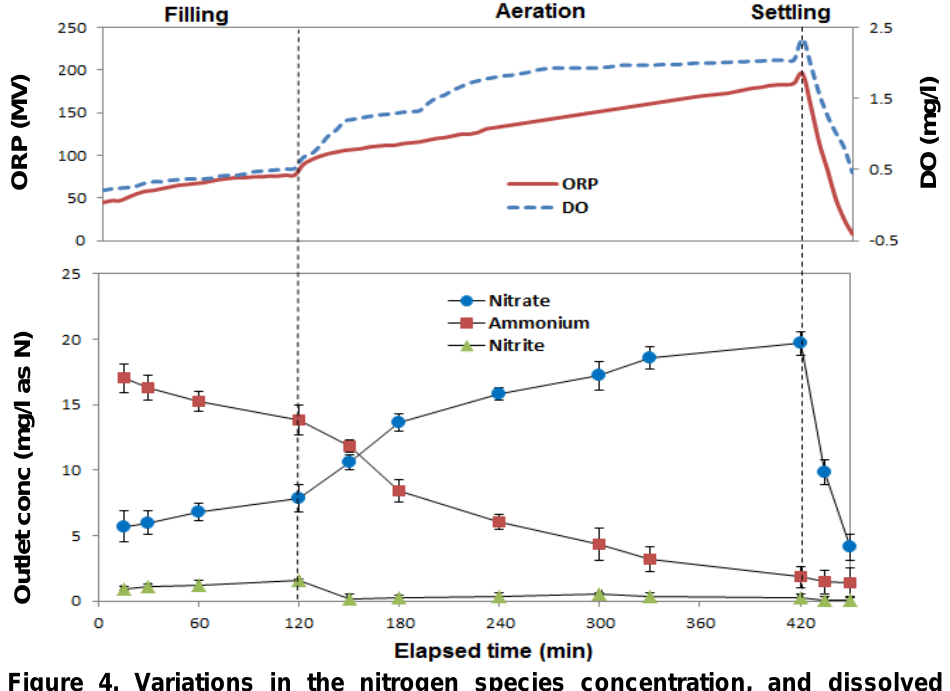
Figure 4. Variations in the nitrogen species concentration, and dissolved oxygen (DO) and oxidation-reduction potential (ORP) values versus elapsed time (Initial ammonium concentration = 25 mg NH 4